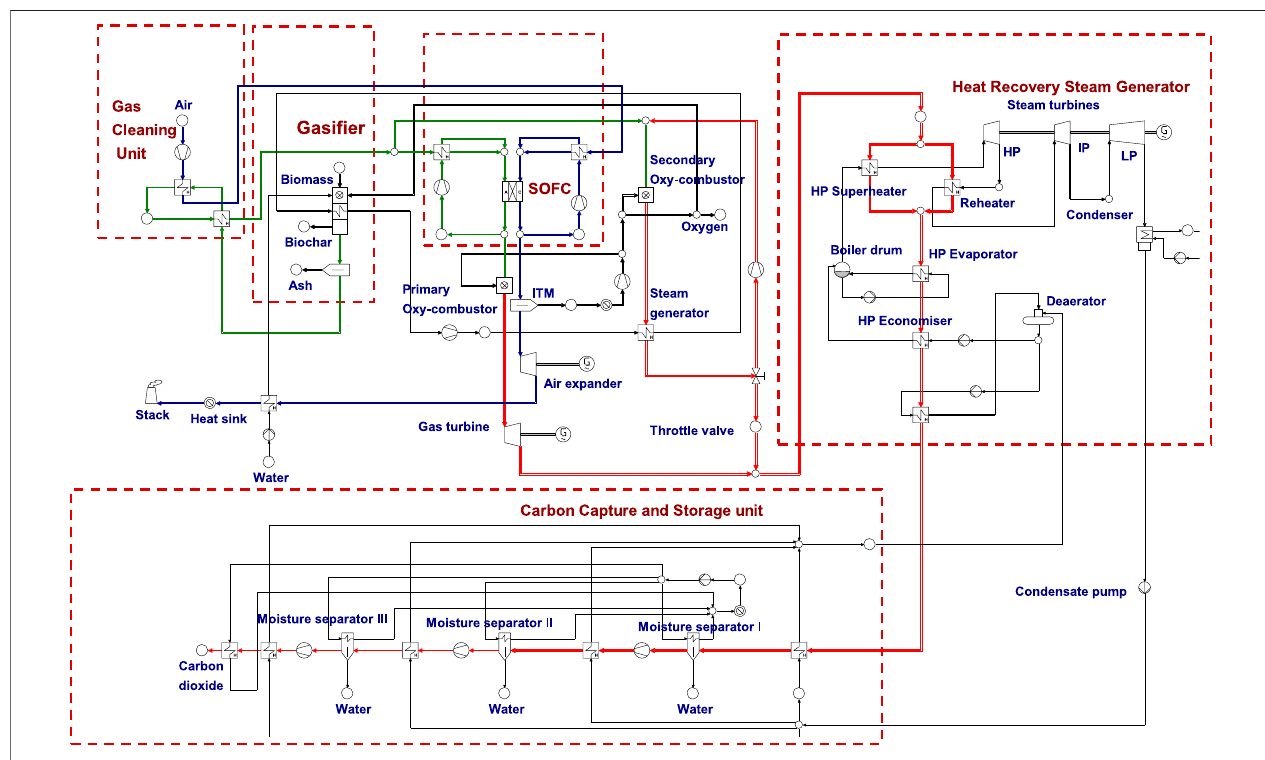
FIGURE2| ProcessschemeoftheBIGFC/CCSsystemforthesteam-oxygengasi fi cationcase — greenstreamsrepresentsyngas fl ow,redstreamsrepresent fl ue gas, and blue streams represent air fl ow. (For interpretation of the references to color in this Fig. legend, the reader is referred to the web version of this article).